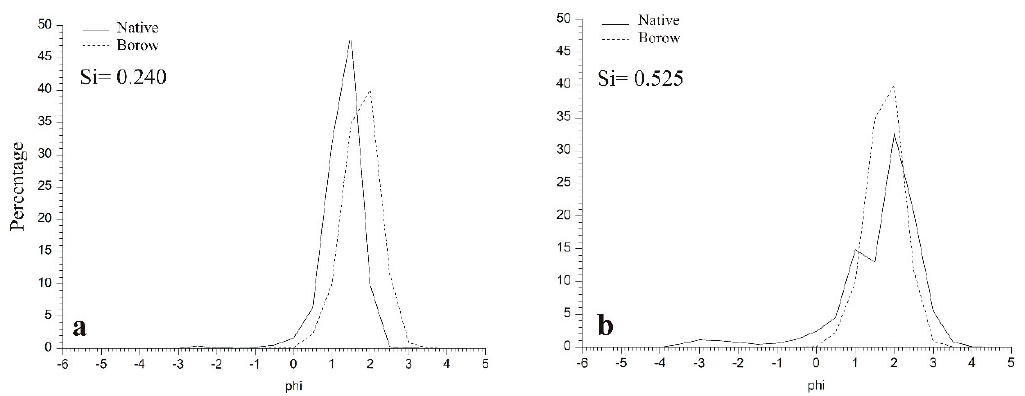
Figure 9. Grain size distribution of the composite sample formed with samples of the borrow area, Marina di Grosseto (12 cores of 4 samples each), compared with those of the potential fill beaches to the northern end of the sedimentary cell (Sectors 39 and 40, a , native sand at Roccamare beach) and that representing the beach north of the Ombrone River mouth (Sector 45; 8 samples, b ).